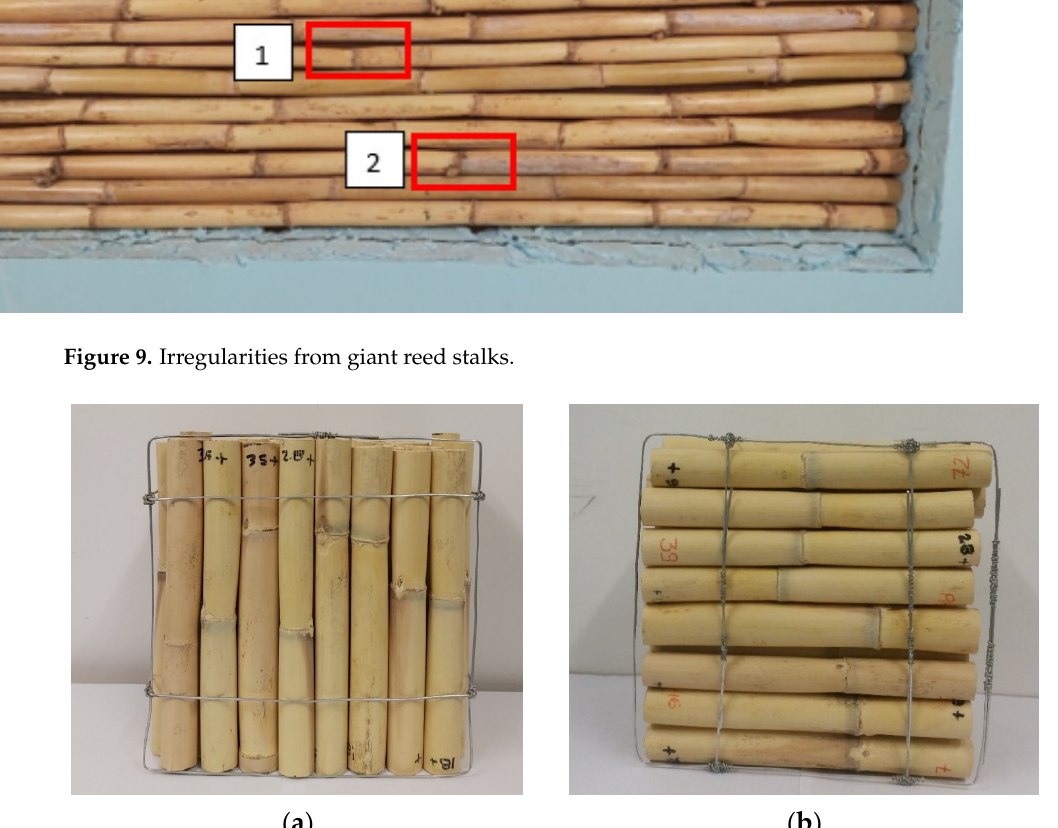
Figure 9. Irregularities from giant reed stalks.